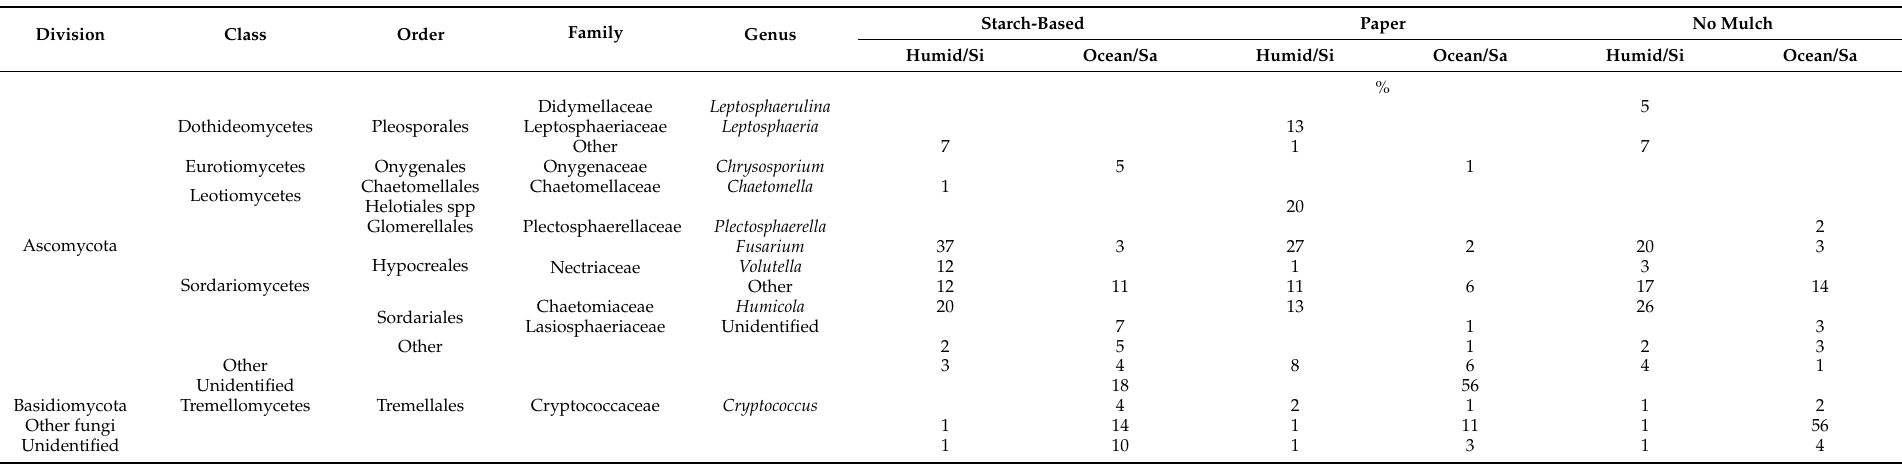
Table 4. Populations of fungi, expressed as percentages and divided by taxa, found in the soil close contact with two biodegradable mulches and in two locations. Humid/Si: location with humid subtropical climate (Cfa, according to the Köppen classification) and silt loam soil. Ocean/Sa: location with temperate oceanic climate (Cfb, according to the Köppen classification) and sandy loam soil. Values below 1% were excluded. Adapted from Moore-Kucera et al.